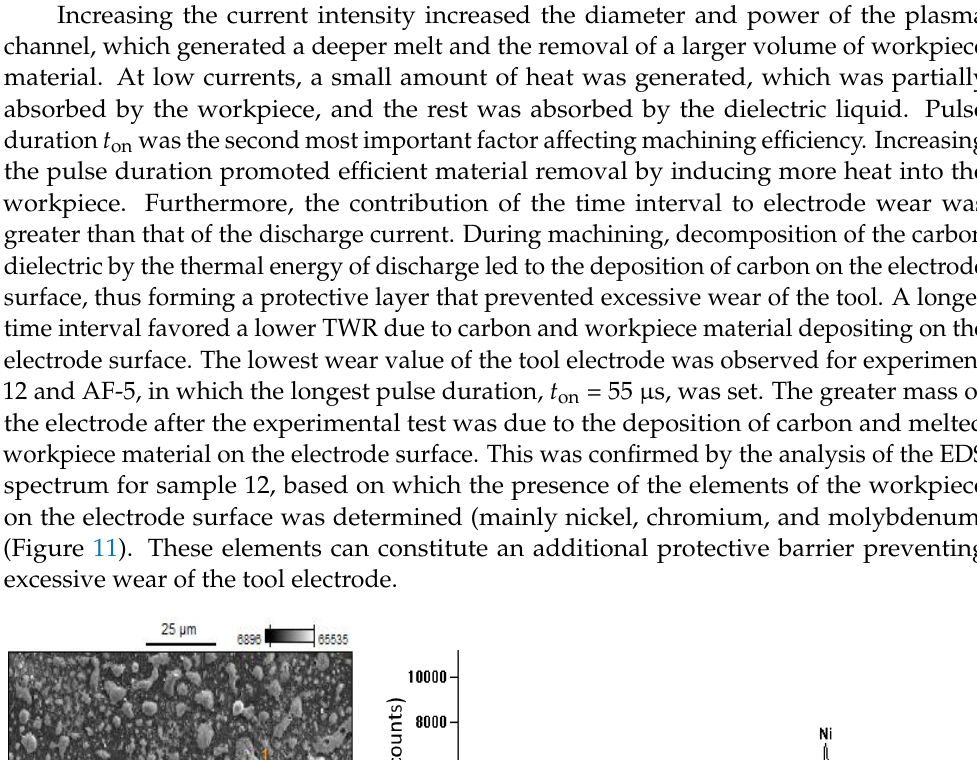
on = 55 µ s, t off = 37 µ